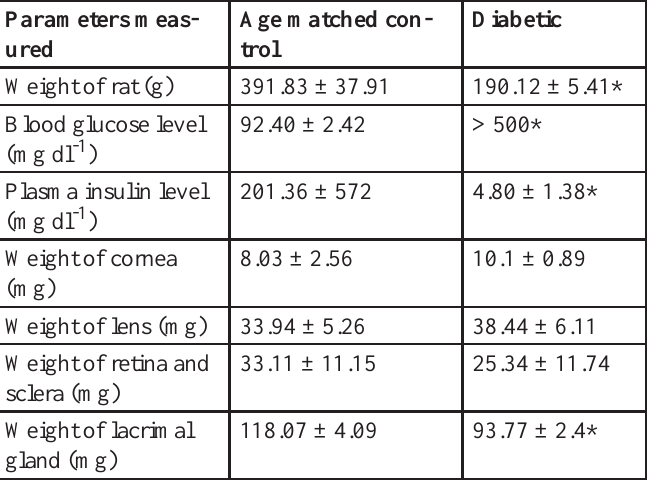
Table 1: Characteristics of animals and weights of rat ocular tis- sues. Data were mean ±SEM, N=7, *Significantly different from age-matched control mice ( p < 0.05).